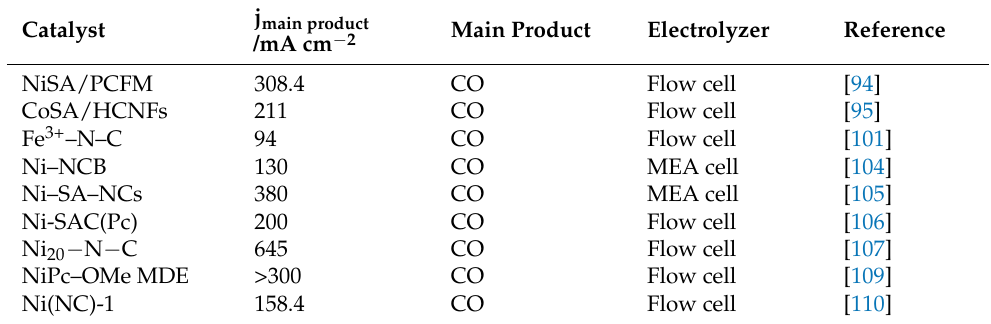
Table 6. CO 2 electroreduction performances of single-atom catalysts.